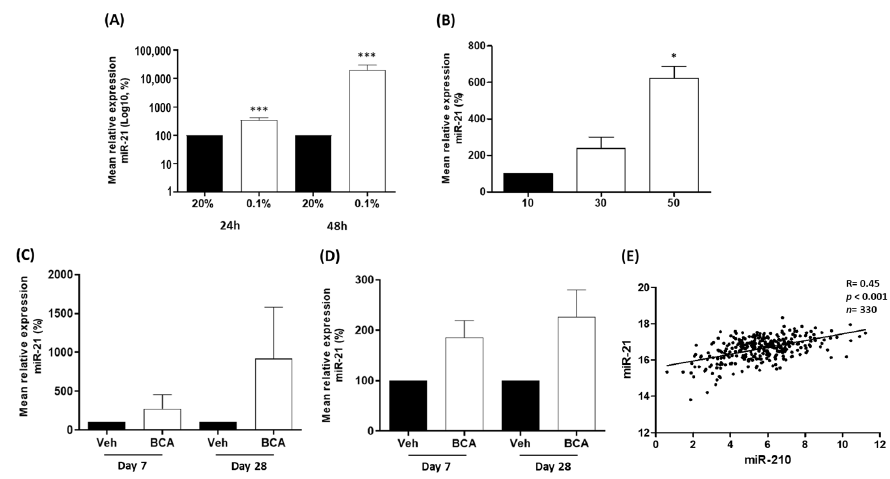
Figure 2. miR-21 is up-regulated by hypoxia in vitro and in vivo. ( A ) After 24 and 48 h (h) of hypoxia (0.1% oxygen), miR-21 expression is significantly increased relative to atmospheric oxygen levels (20%) in LNCaP cells. ( B ) In LNCaP spheroids, miR-21 expression is significantly elevated as spheroid size (and associated hypoxia) increases. (Both paired t -test, * p < 0.05, *** p < 0.001). In bicalutamide-treated (BCA) mice with xenograft LNCaP tumours, miR-21 is increased in the ( C ) tumours and ( D ) serum at Day 7 and Day 28, relative to vehicle-treated (Veh) animals ( n = 4 mice per group). ( E ) Regulome Explorer analysis revealed significant positive correlation between expression of hypoxia-induced miR-210 and miR-21 (Pearson correlation, p < 0.001). All bar graphs show mean ± SEM of at least three biological replicates. Table 2. Functional enrichment analysis of miR ‐ 21 related to hypoxia. Table shows the significant association of miR ‐ 21 target genes with Gene Set descriptions related to hypoxia. Analysis per ‐ formed using clusterProfiler in CancerMIRNome.